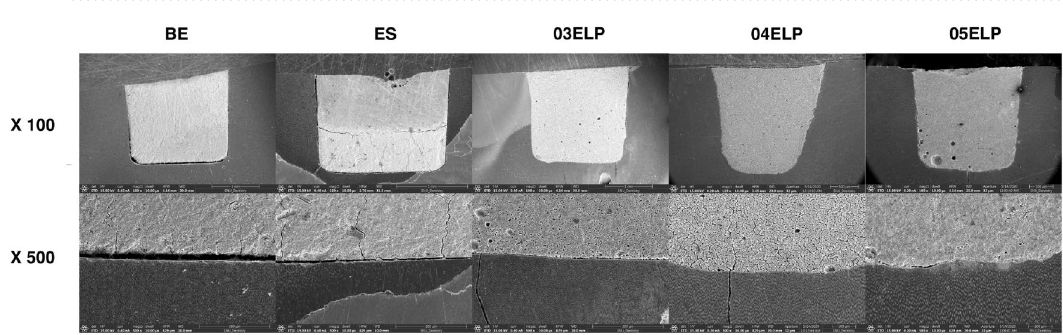
Figure 3. Sealer penetration level of the experimental groups. ( a ) Representative images of confocal laser scanning microscopic photograph (×10) showing the penetration of sealer to the dentinal tubules. ( b ) Mean percentage of sealer penetration. Numbers in parentheses present standard deviation values. Different lower letters on top of the bar denote statistically significant differences between groups (P < 0.05).